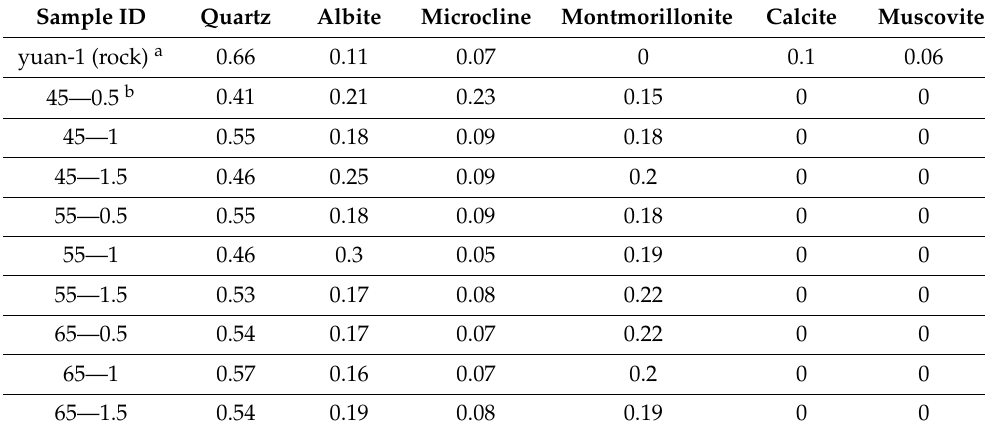
Table 5. Mineral composition in ground sandstone specimens before and after displacement experi-